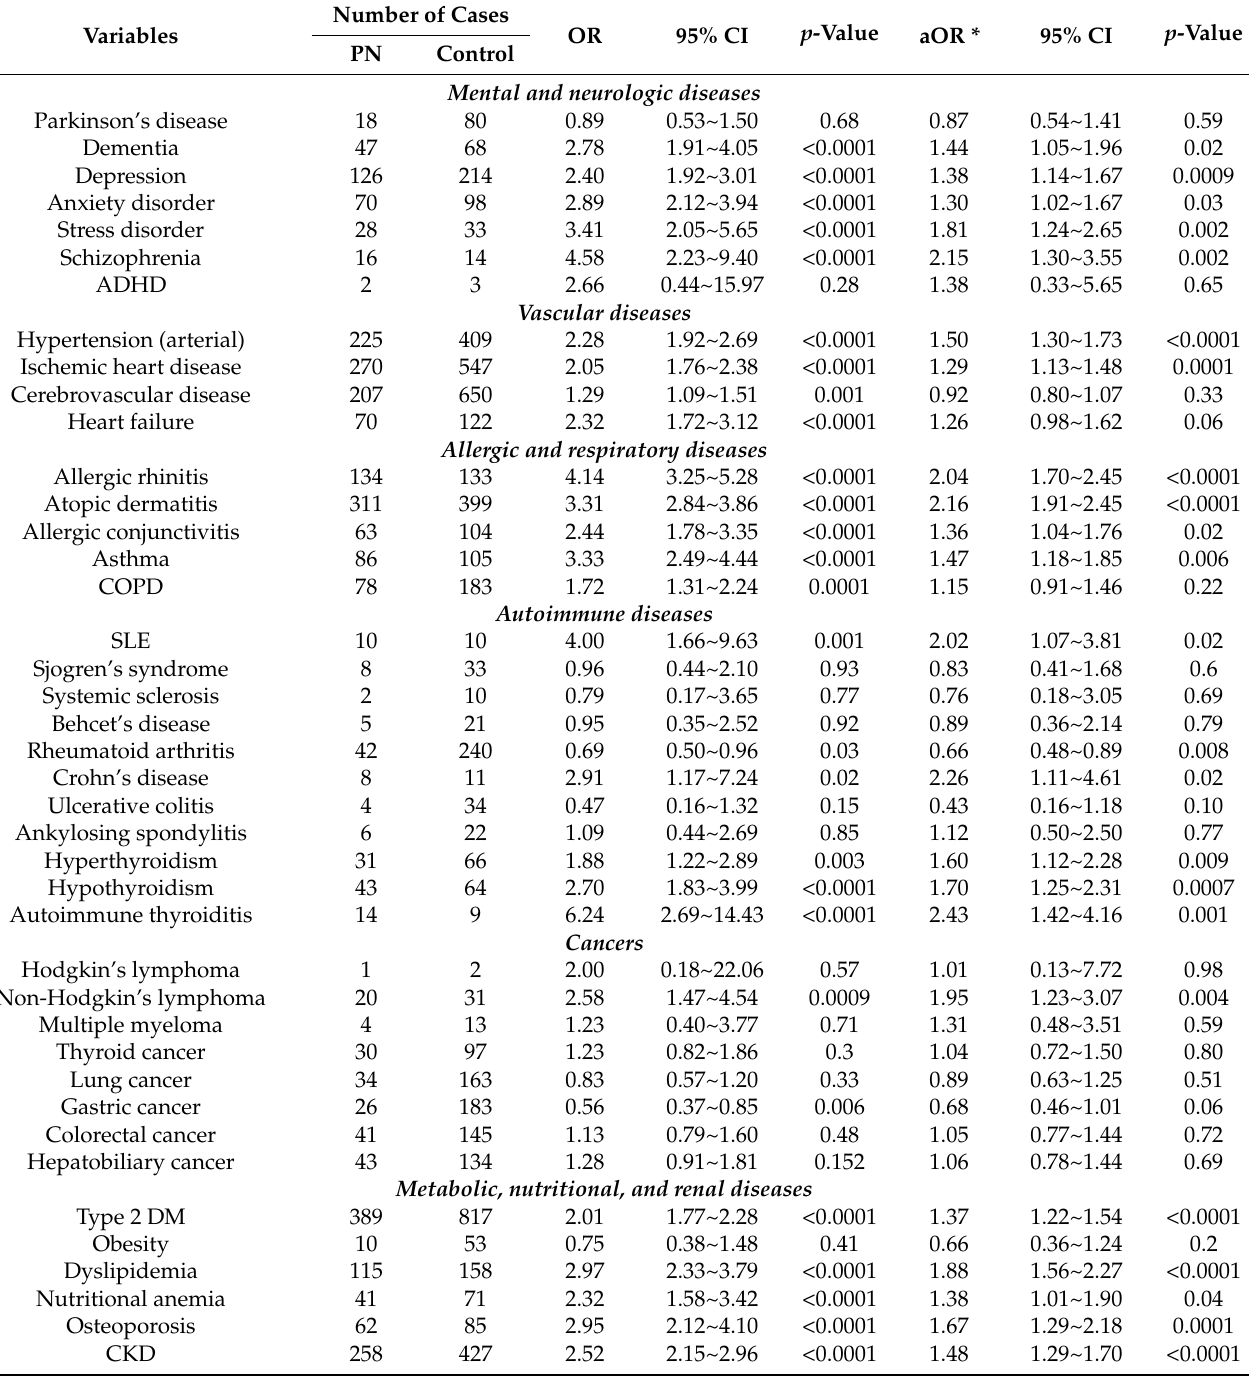
Table 3. Association between PN and various systemic